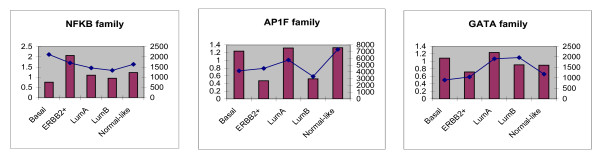
Correlation between TF overrepresentation and corresponding TF gene in each subtype. Correlation between geometric mean of TF gene expressions in each subtype (shown as red bars) and their corresponding TF matrix family overrepresented in subtype-specific promoter sequences (shown as blue points) is plotted